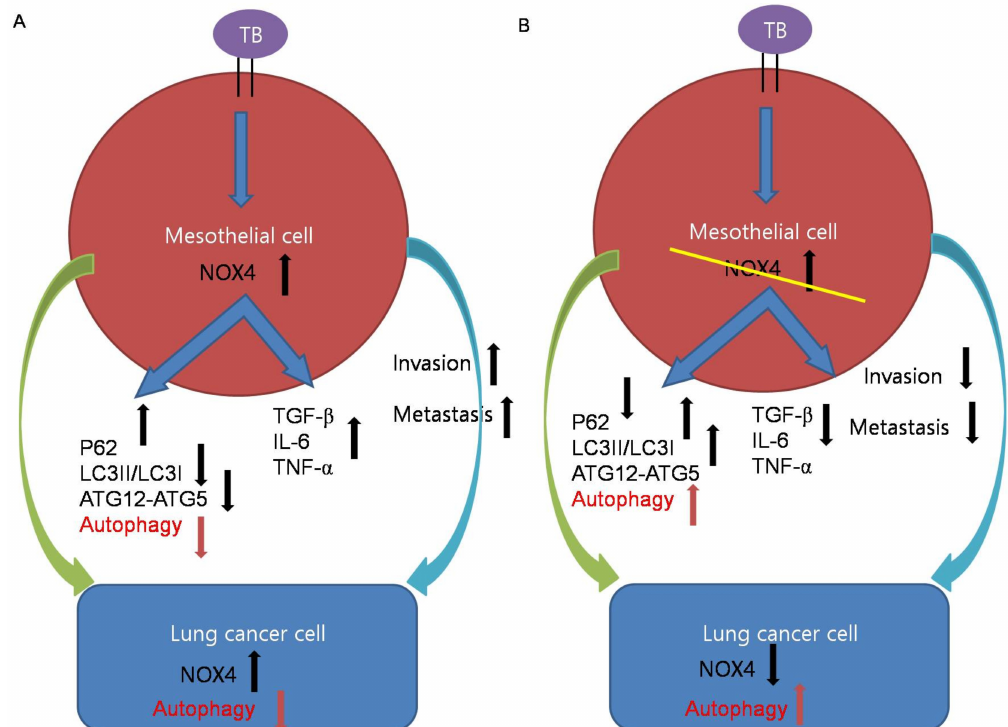
Figure 6. Schematic illustrations of the mechanism by which tuberculous fibrosis contributes to the malignant potential of lung cancer. ( A ) TB-infected PMCs exhibited increased expression of NOX4. NOX4 downregulates autophagy signaling and induces TGF- β , IL-6, and TNF- α , leading to cancer cell proliferation. In lung cancer cells after exposure to TB-infected PMCs, NOX4 signaling increases and autophagy signaling decreases. ( B ) Knockdown of NOX4 in TB-infected PMCs increases autophagy signaling and reduces TGF- β , IL-6, and TNF- α , leading to cancer